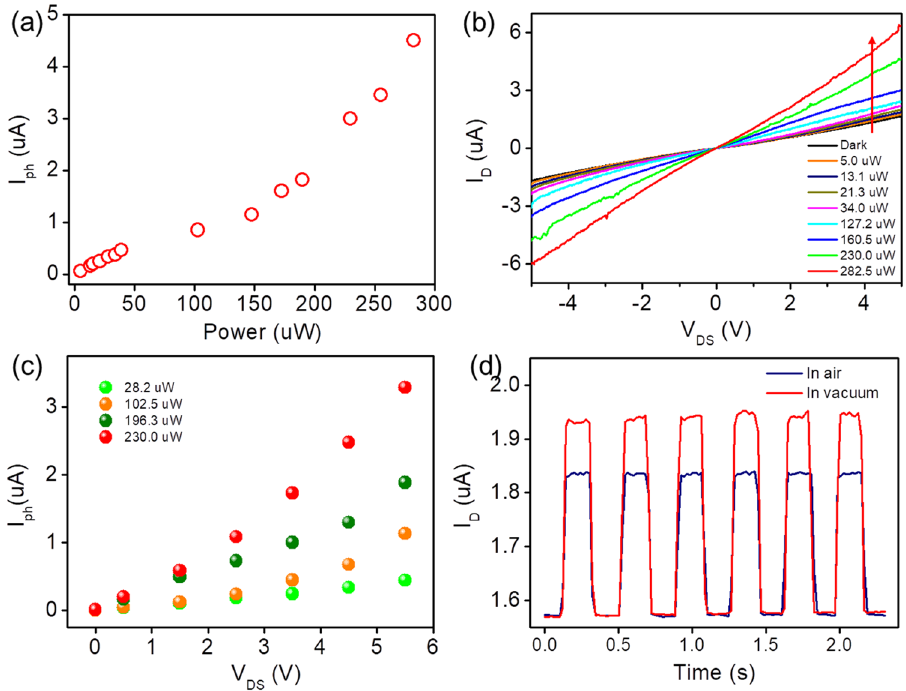
Figure 6. (a) Photocurrent versus light power plot at bias of 5.0 V. (b) I–V curves of the device at different IR radiation intensities. (c) Photocurrent versus bias voltage under varying light power. (d) Time-dependent photoresponse of the device in vacuum and